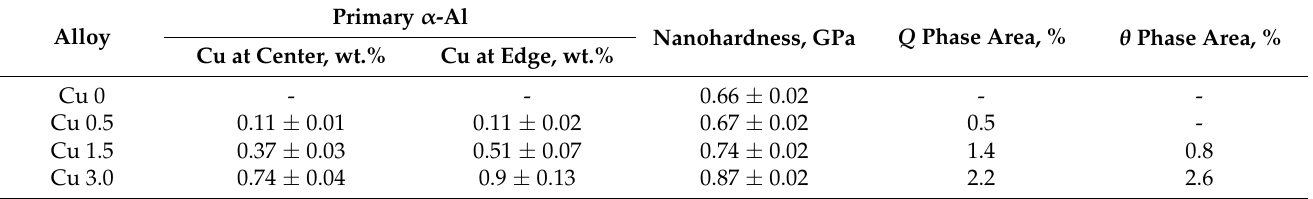
Table 4. Influence of Cu content on microstructural components in Al-7%Si-0.4%Mg alloy [151]. Primary α -Al Alloy Nanohardness, GPa Q Phase Area, % θ Phase Area, % Cu at Center, wt.% Cu at Edge,